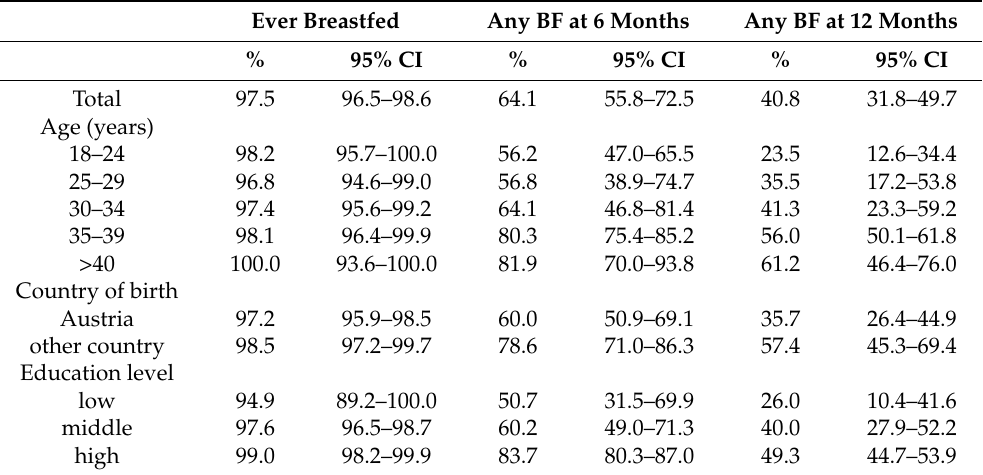
Table 1. Prevalence of mothers who had ever breastfed and breastfeeding mothers at 6 and 12 months after delivery separated by age, country of birth and education level in % of population ( n = 1.214). Ever